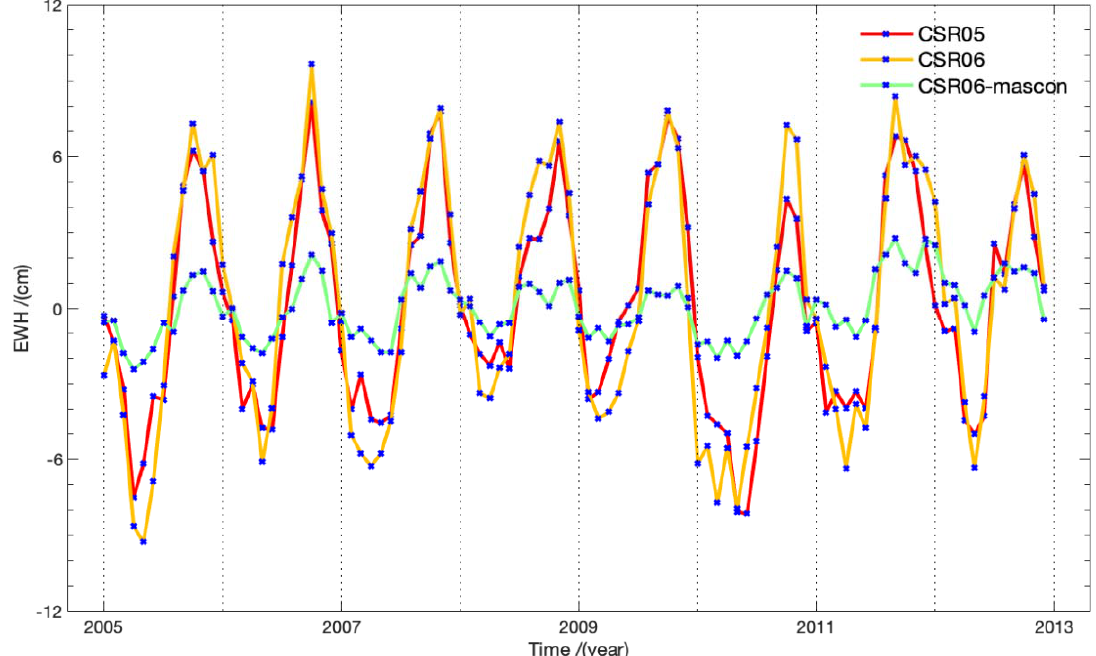
Figure 3. The average gridded EWH time series for GRACE CSR05, CSR06 and CSR06-mascon data products over 9–15 ◦ N, 110–114 ◦ E in the western SCS during 2005–2012.